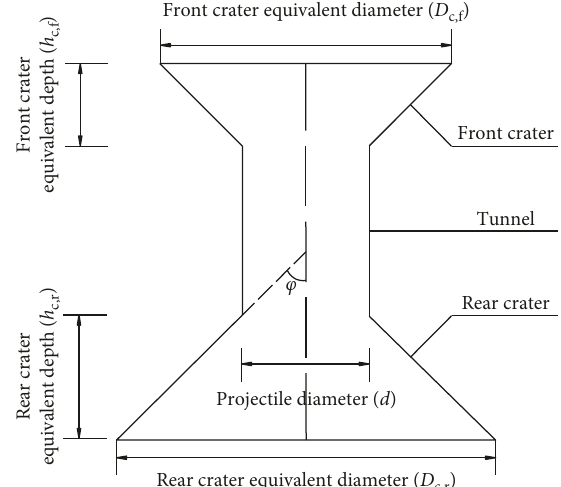
Figure 2: Three stages of the perforation damage in concrete